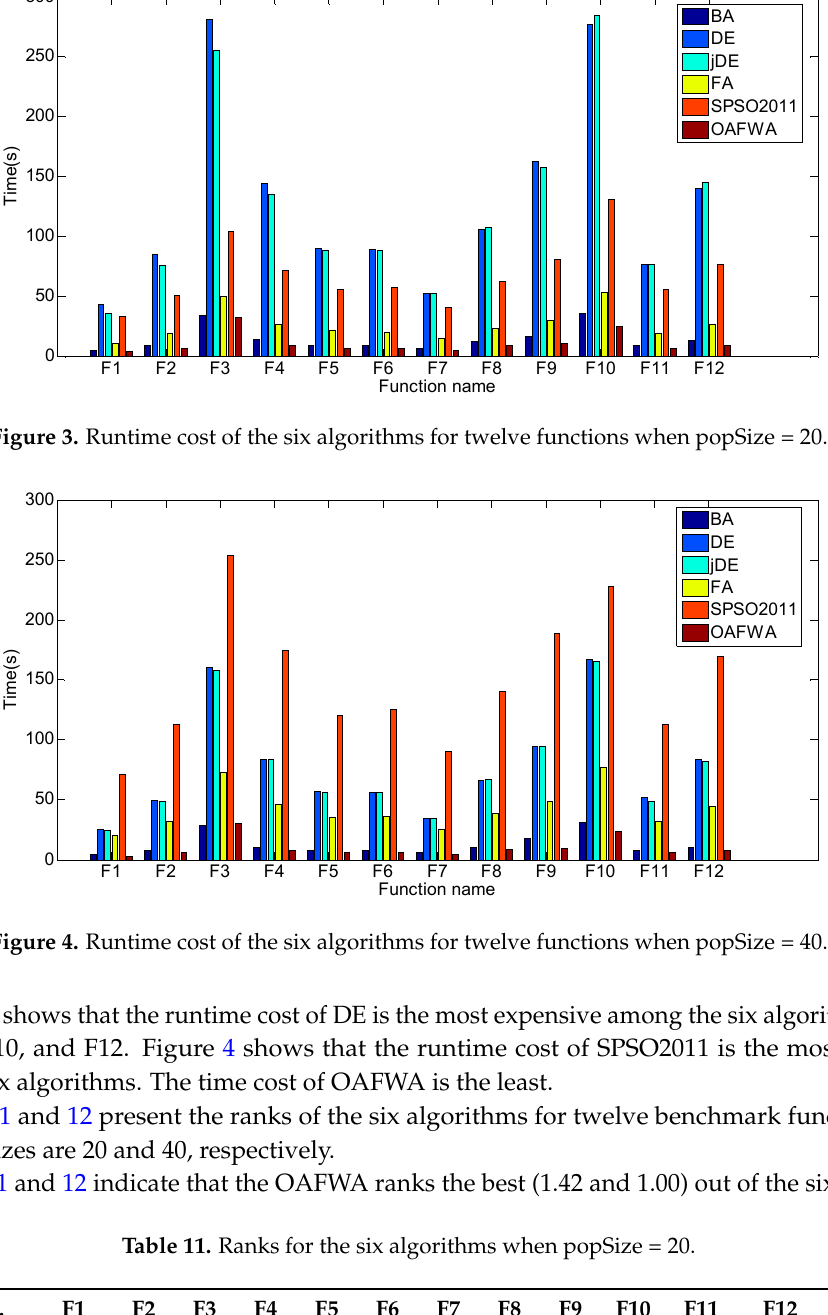
Table 11. Ranks for the six algorithms when popSize = 20.